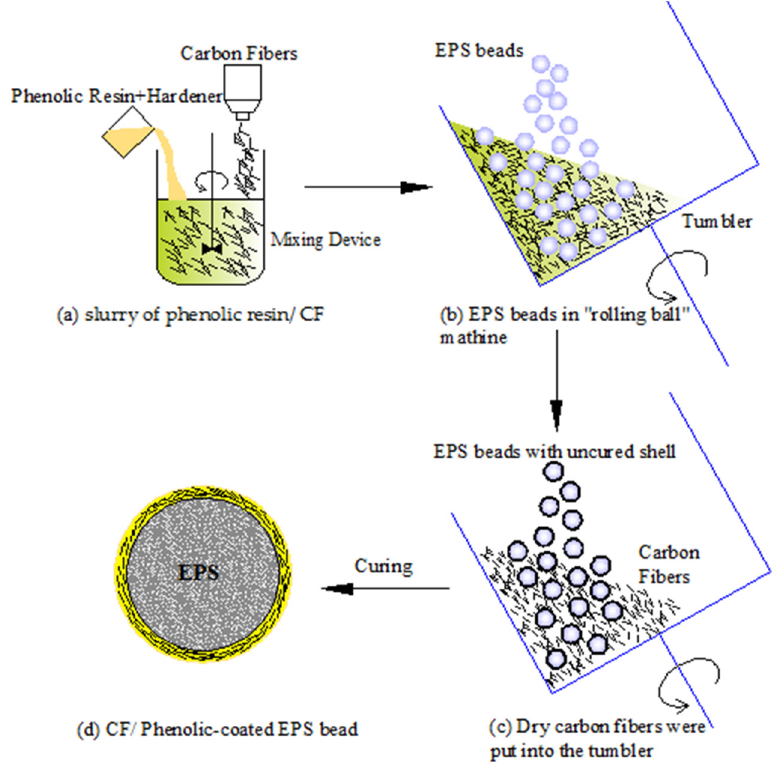
Figure 2. Fabricating procedures by “rolling ball” method: ( a ) slurry of the phenolic resin/CF; ( b ) EPS beads in “rolling ball machine”; ( c ) dry carbon fibers were put into the tumbler; ( d ) CF/Phenolic coated EPS bead.